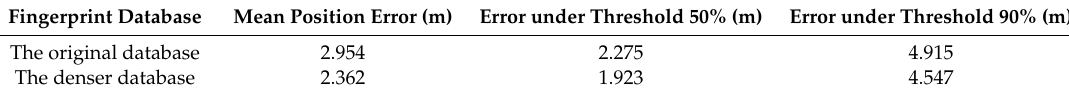
Table 3. Comparison of positioning performances with di ff erent fingerprint databases.